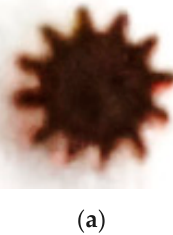
Figure 11. Micrograph of formed gear and die. ( a ) Micro gear parts formed by machining, ( b ) Partial screenshot of die gear teeth